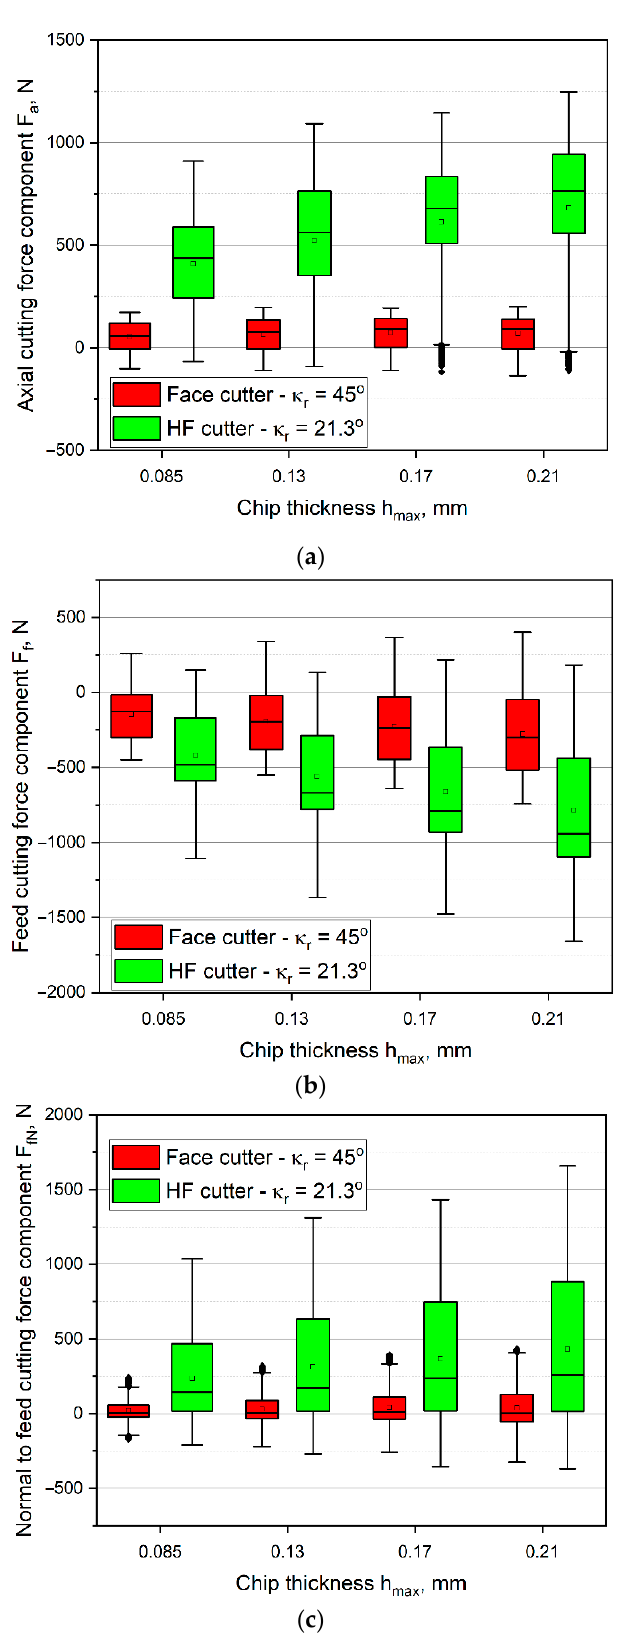
Figure 7. Cutting force components as a function of chip thickness in up milling with v c = 150 m/min, f z = 0.14–0.35 mm/tooth for face mill, and f z = 0.28–0.68 mm/tooth for HF mill: ( a ) F a , ( b ) F f , ( c ) F fN .